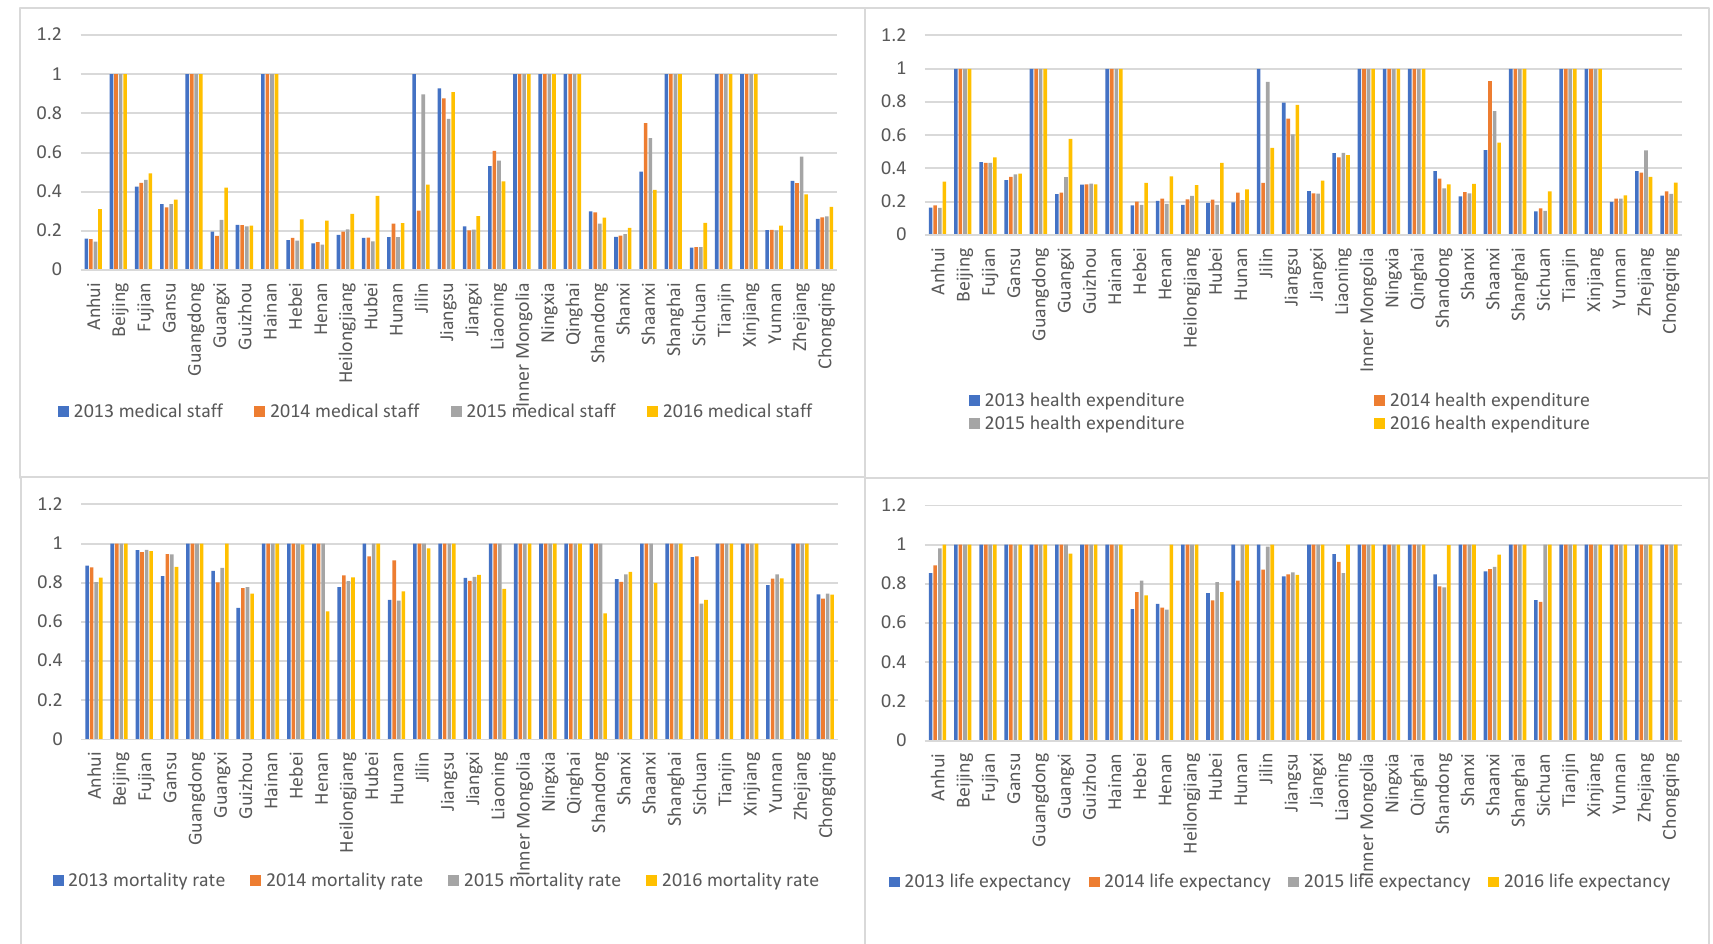
Figure A2. Efficiency of the second stage input-output indicator in 2013–2016. Figure A2. E ffi ciency of the second stage input-output indicator in